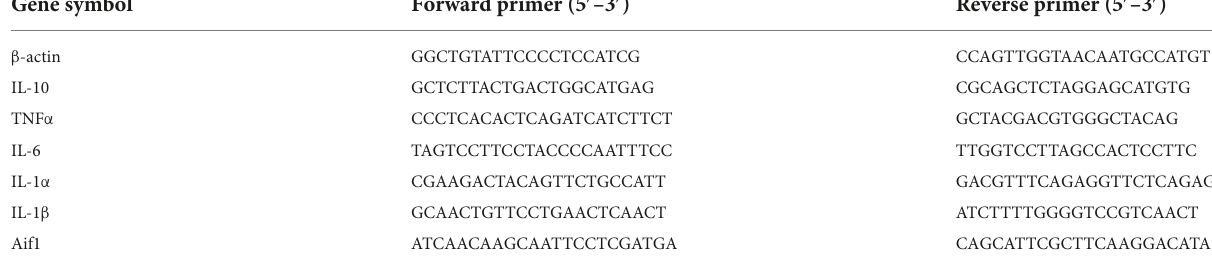
TABLE 1 Primer list. Gene